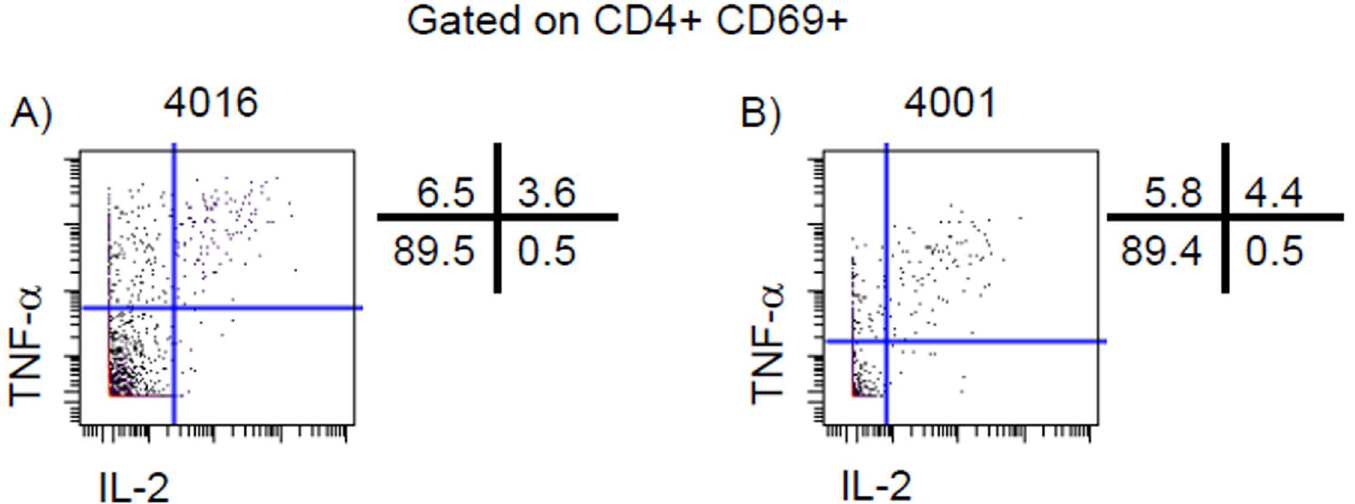
Fig 2. Multifunctional CD4+ T cells. TNF- α and IL-2 multifunctional CD4+ T cells followingCFA/I stimulationon day 3 post infectionin Resistant volunteers A) 4016 and B) 4001.